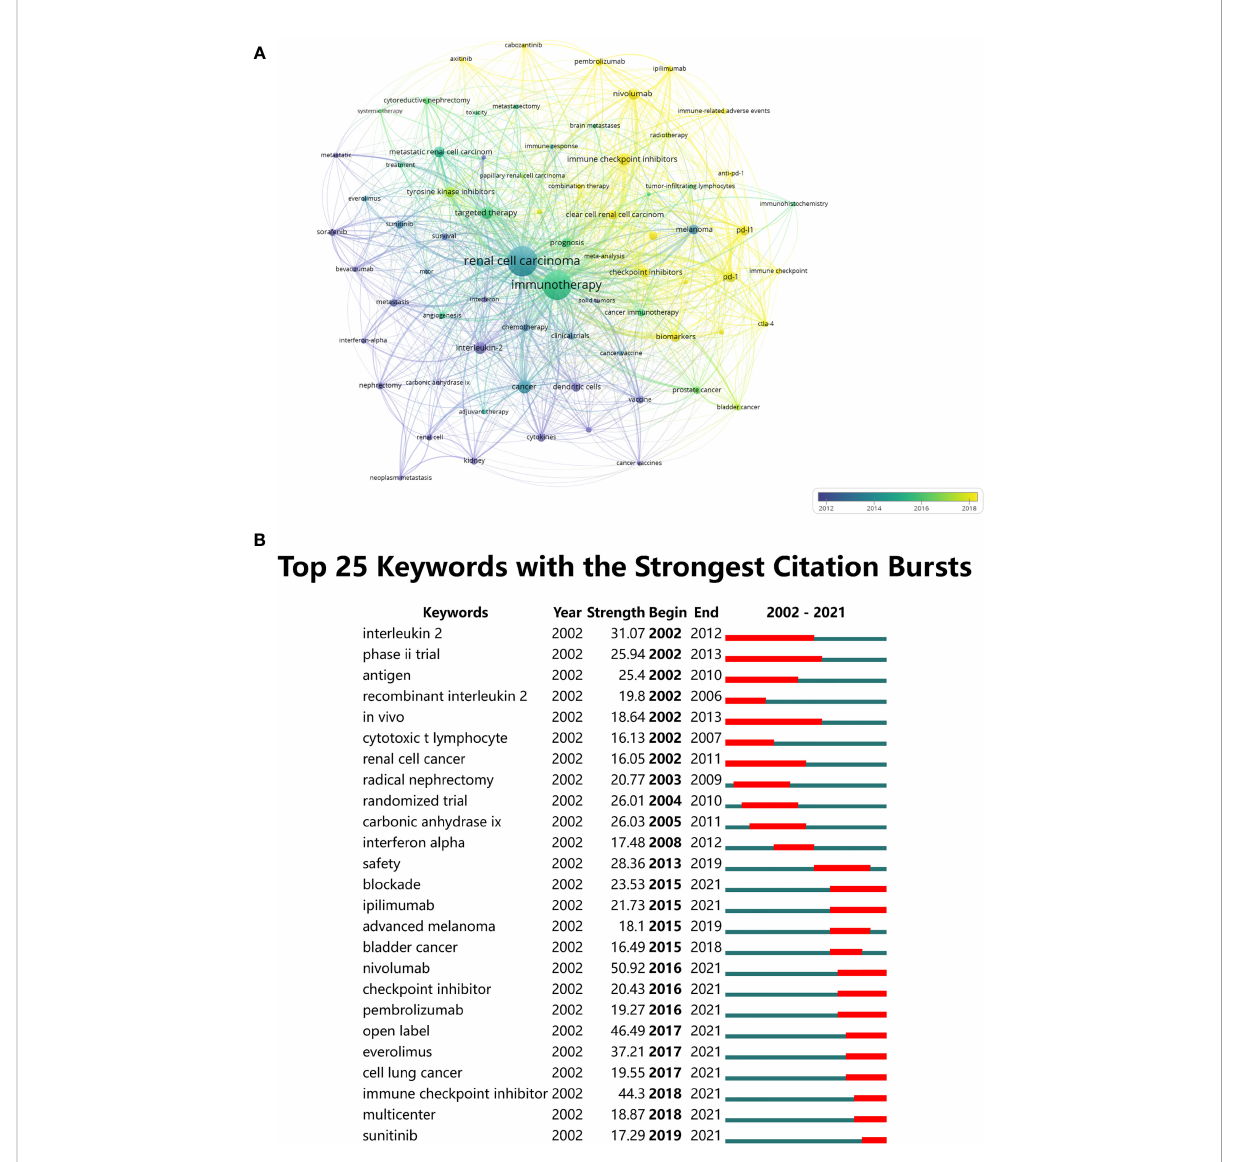
FIGURE 8 (A) The time-overlay visualization map of the co-occurrence keywords generated by using VOSviewer. (B) CiteSpace visualization map of top 25 keywords with the strongest citation bursts of publications in the fi eld of RCC immunotherapy from 2002 to